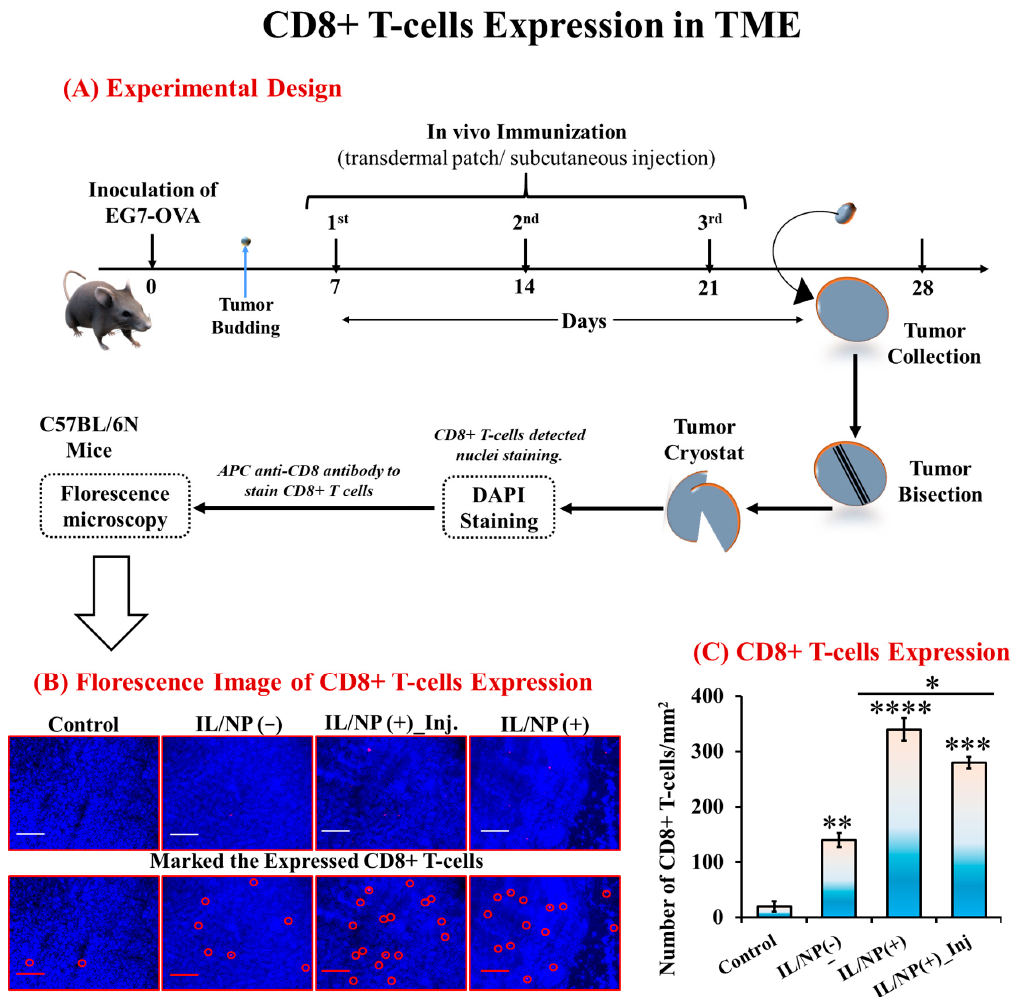
Figure 7. Number of CD8+ T cells in the TME following nanovaccination: ( A ) experimental design, ( B ) microscopic image, and ( C ) statistical analysis of CD8+ T-cell counts. Data are presented as the mean ± SD (n = 3). * p < 0.1, ** p < 0.01, *** p < 0.001, **** p < 0.0001, and Inj = administered via subcutaneous injection.